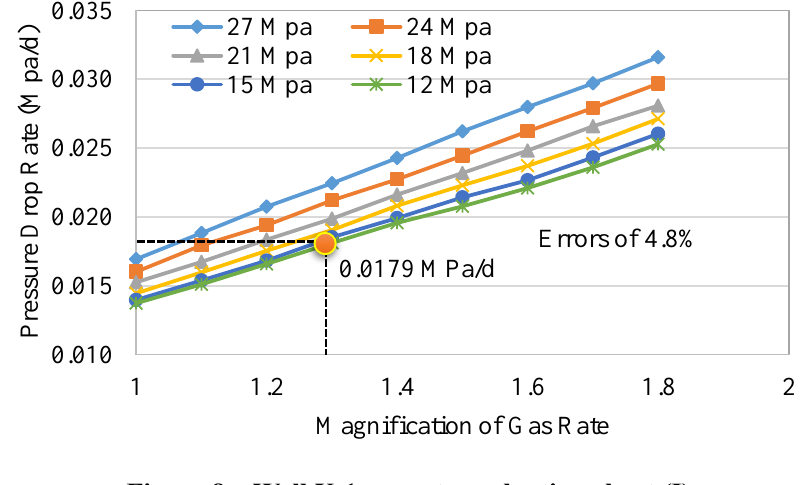
Figure 8—Well X-1 gas rate evaluation chart (I).